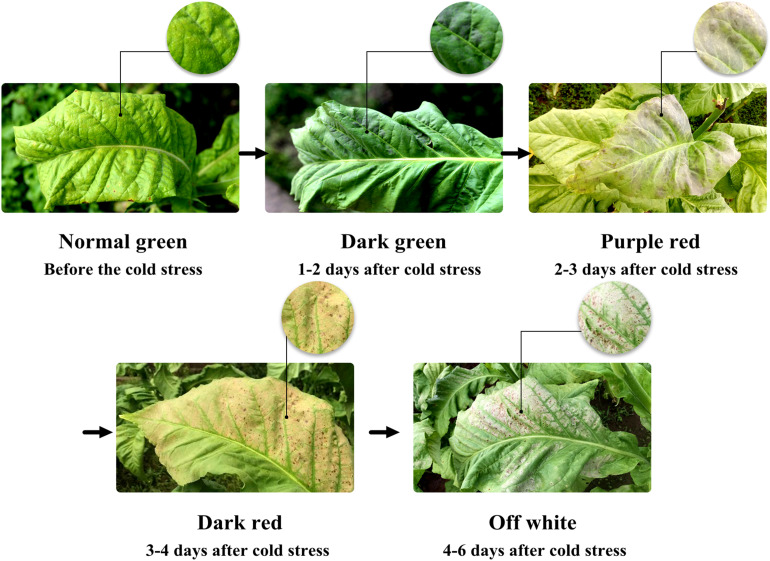
Dynamic symptoms of tobacco after cold stress.